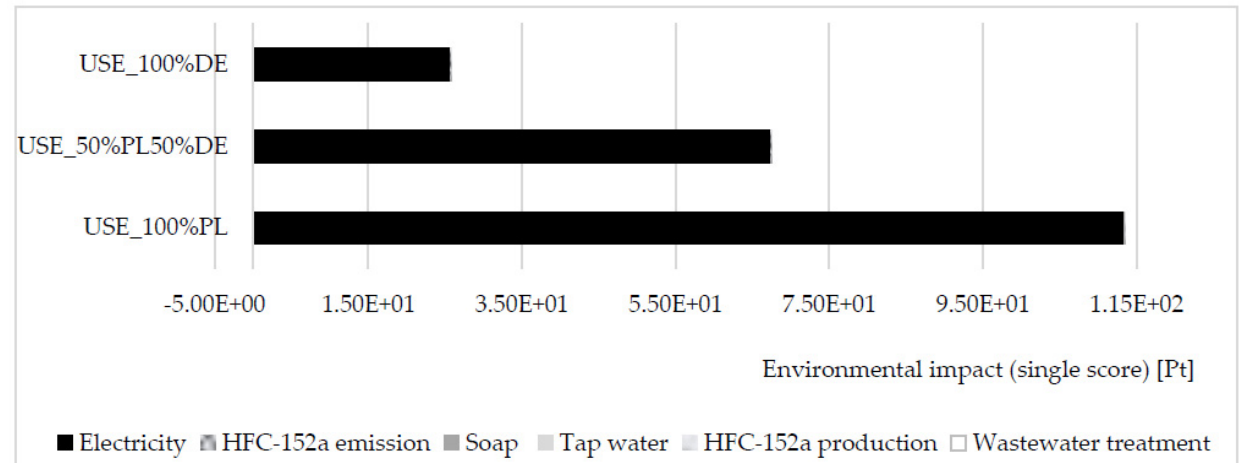
Figure 4. Environmental impact of the life cycle stage Retail (RETA) per 1 refrigerator (0.271 Pt = 100%DE, 0.711 Pt = 50%PL50%DE, 1.196 Pt = 100% PL, decrease by 77%).